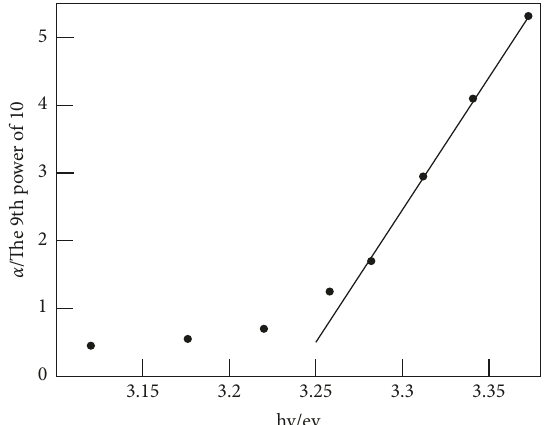
Figure 6: Optical band gap of graphene